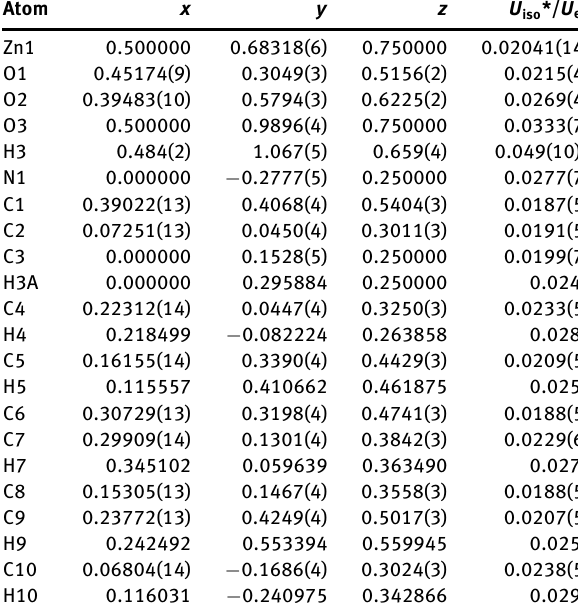
Table 2: Fractional atomic coordinates and isotropic or equivalent isotropic displacement parameters (Å 2